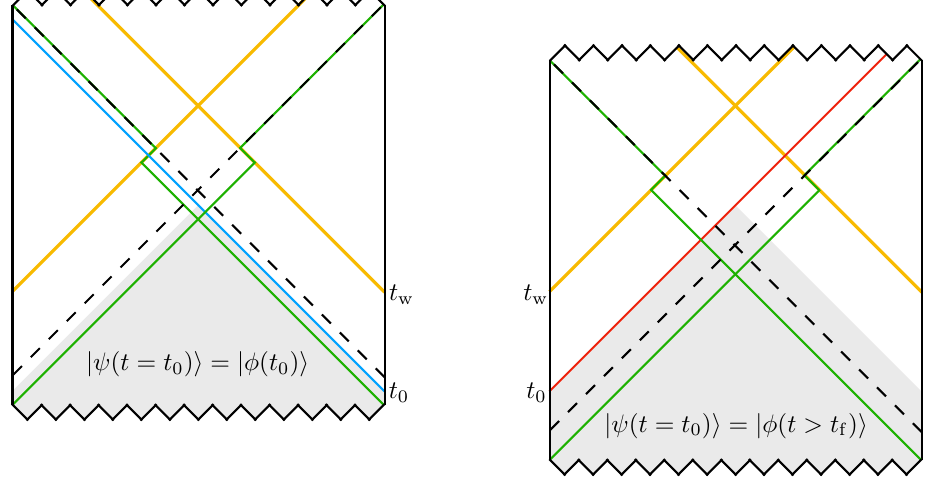
Figure 3 . Di(cid:11)erent outcomes for the double-trace deformation experiment, depending on the state ( t 0 ) at time t 0 , which is dual to the geometry in the corresponding Wheeler-deWitt patch j i (shaded gray). The times of the signal t 0 (blue and red lines) and the double-trace deformation (yellow lines) are (cid:12)xed, but the time coordinate of the geometry can be shifted up and down, due to the time-invariance of the AdS black hole metric. If state at time t 0 , (cid:30) ( t 0 ) (left), or more generally to any j i traversing the wormhole (blue line, left). On the other hand, if the state (cid:30) ( t > t f ) , the signal fails to traverse the wormhole, hitting the singularity (red line, right). j i